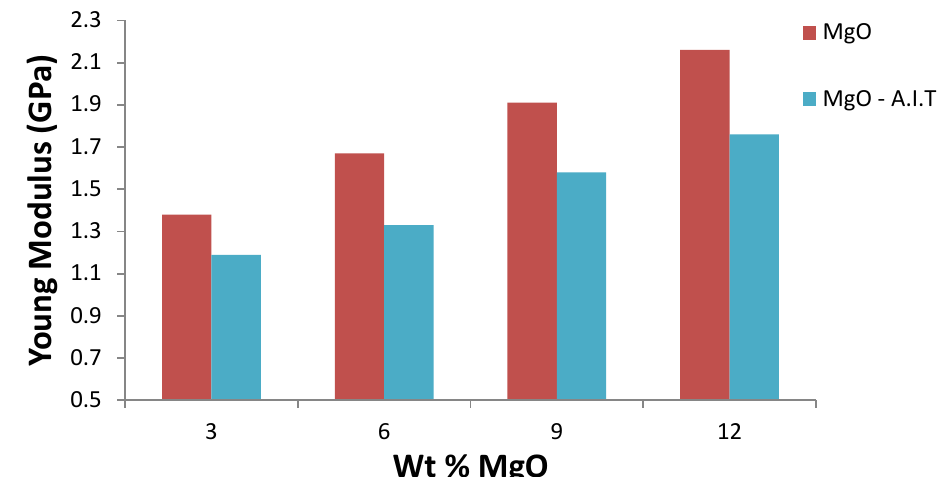
Fig. 6: Comparison of Young's modulus values with different weight fraction of MgO in normal conditions and after immersing in diluted sulfuric acid for 10 days. *A.I.T=after immersion time